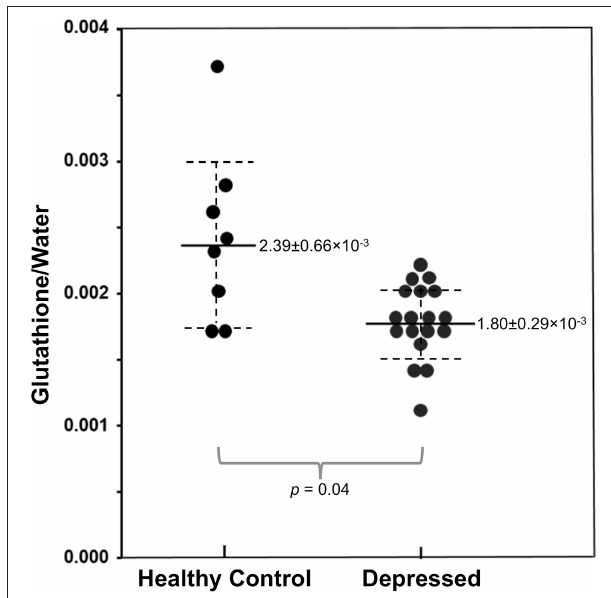
FIGURE 11 | Reduced occipital glutathione relative to unsuppressed water signal in adolescents with major depressive disorder ( N = 19) vs. healthy controls ( N = 8), measured via 1 H MRS. Adapted from ( 179). Solid and dashed lines represent mean and 95% confidence intervals, respectively.